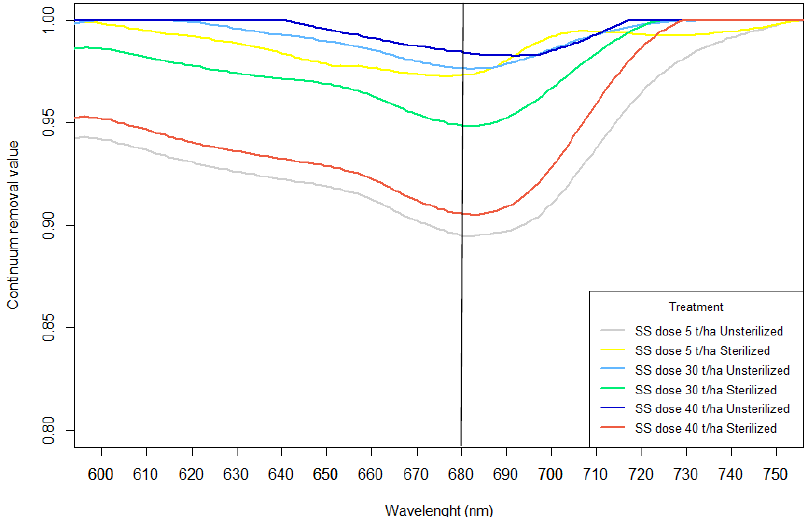
Figure 9. Continuum removal (CR) curve of the cyanobacteria ‐ inoculated soils with the sterilized (S) and unsterilized SS (NS) at the different SS doses, after 4 months.